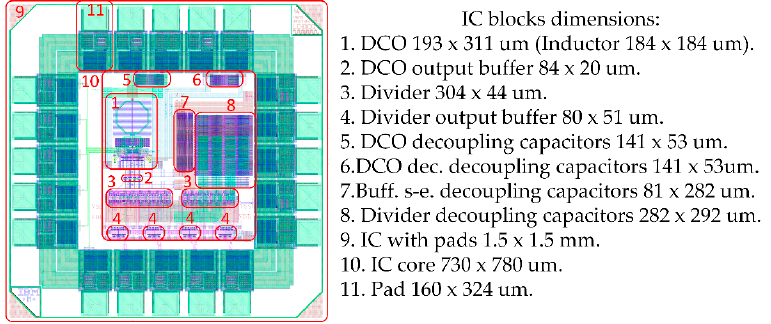
Figure 9. Layout of the proposed LC DCO and E-TSPC frequency divider with pads and dimensions. Electronics 2019 , 8 FOR PEER REVIEW